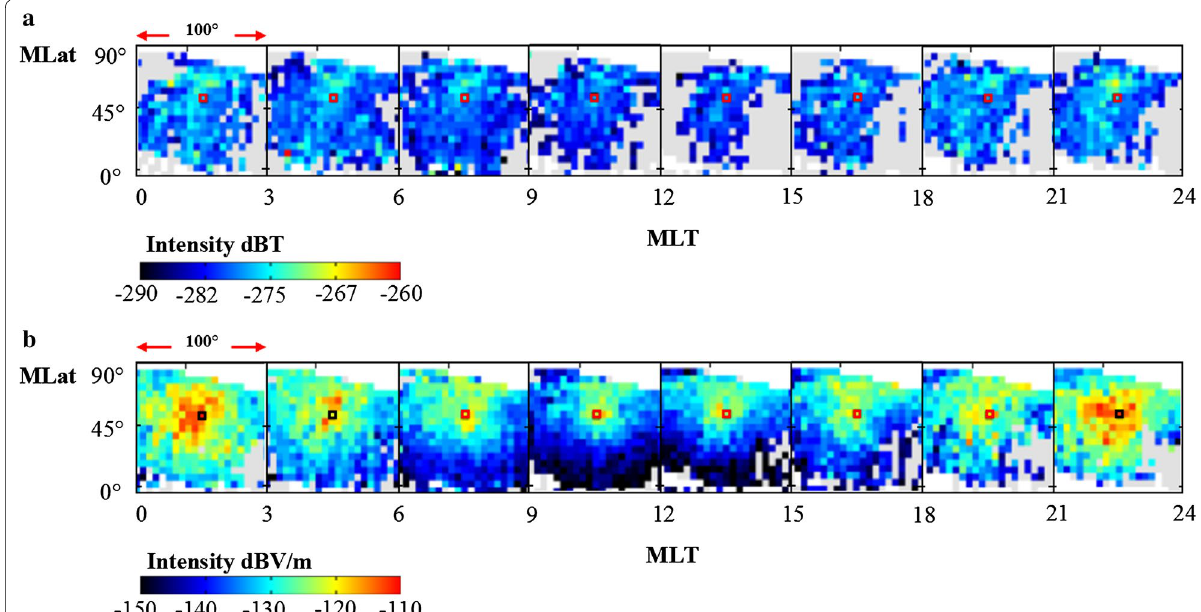
Fig. 6 a Propagation of the Omega signal from the Norway station based on local time in the magnetic field and b in the electric field. The red arrow indicates the width of the map (~100°) with location of the station in the center (indicated by the rectangle